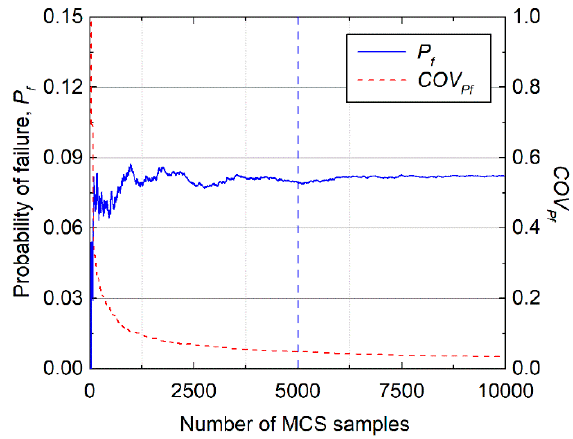
Figure 2. Number of Monte Carlo simulation (MCS) samples versus (cid:1842) (cid:3033) and (cid:1829)(cid:1841)(cid:1848) (cid:3017)